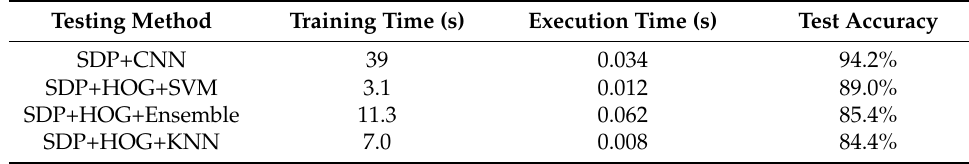
Table 1. Test accuracy results of different